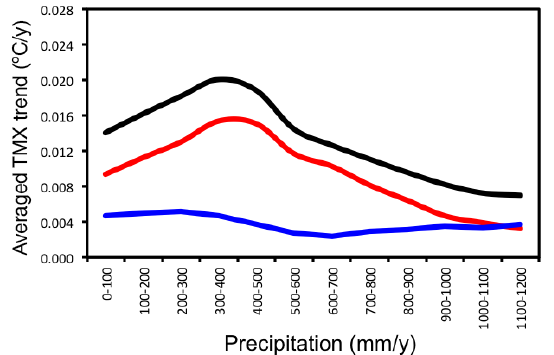
Figure 10. Same as Fig. 6, except for daily maximum temperature (TMX).